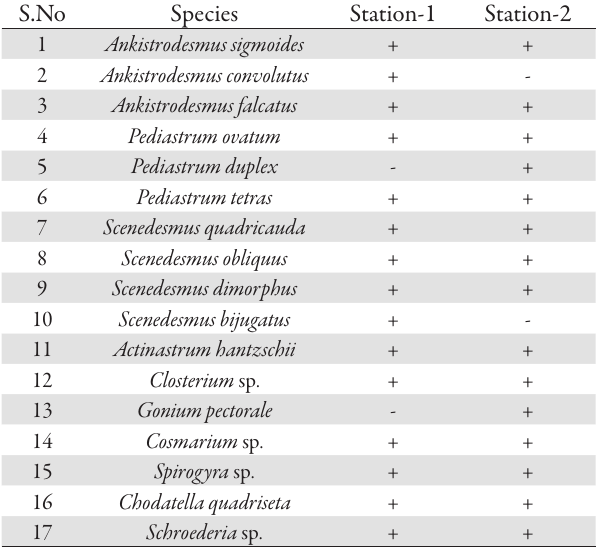
Tab. 1. Table shows the Phytoplankton of Chlorophyceae in Station-1 and